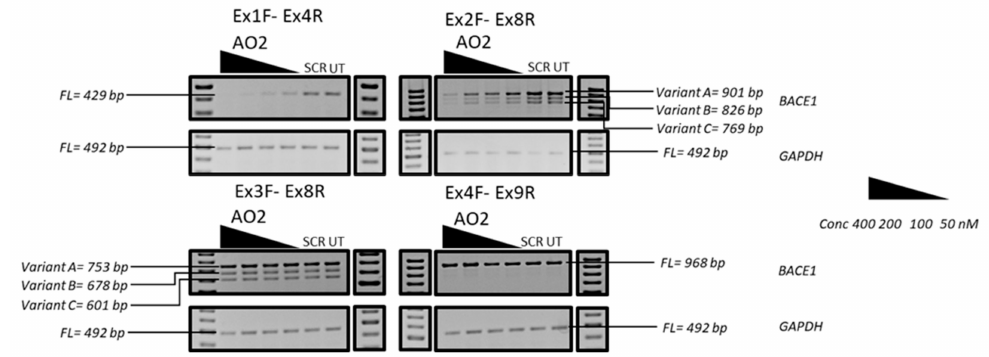
Figure 6. Representative RT-PCR analysis of the BACE1 and GAPDH transcripts after treatment with AO2 targeting exons 2 at 400 nM, 200 nM, 100 nM, and 50 nM in HEK293 cells. Specific regions of the RNA were amplified by di ff erent primer sets. Exons 1–4 were amplified using primer set Ex1F-Ex4R, exons 2–8 were amplified using primer set Ex2F-Ex8R, exons 3–8 were amplified using primer set Ex3F-Ex8R, and exons 4–9 were amplified using primer set Ex4F-Ex9R. FL, full-length; UT, untreated; SCR, scrambled sequence; GAPDH was used as a loading control. The gel images were cropped to highlight the BACE1 specific products and the corresponding house-keeping gene control GAPDH .